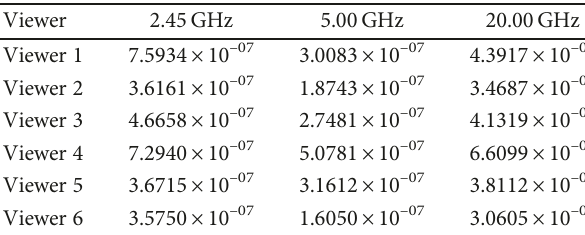
Figure 12: Energy decay as a function of time for the parabolic plate experiment. We observe the correct energy dissipation after the source is turned o ff ( n = 580 ). Table 3: Mean squared error ( E z ) for each viewer in the parabolic re fl ector experiment, between the CPML and the reference solutions, for operation frequencies of 2.45GHz, 5.00GHz, and